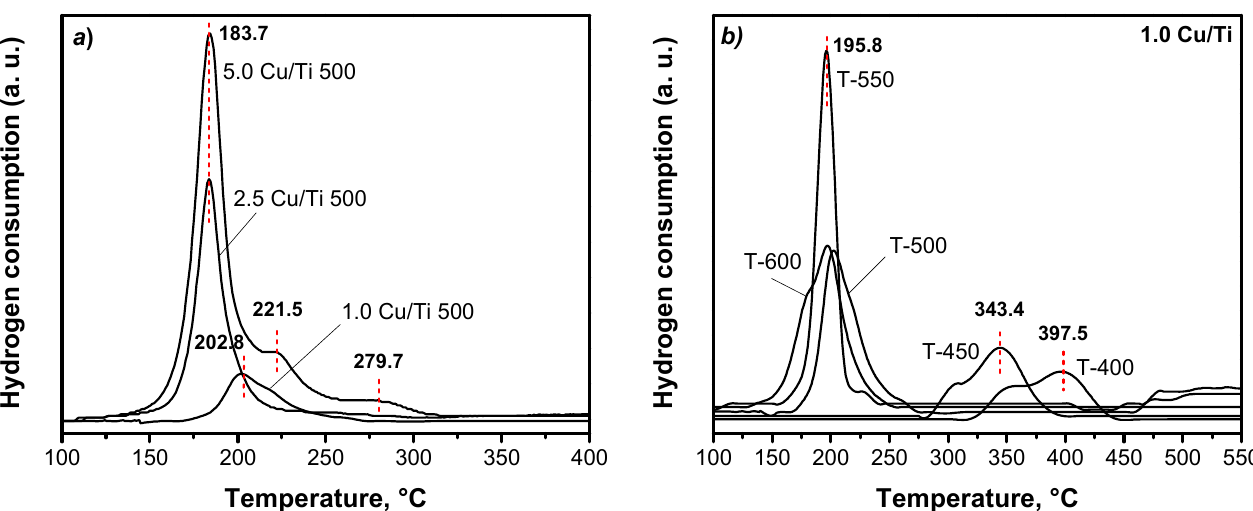
Figure 4. Temperature-programmed reduction of ( a ) X Cu/Ti and ( b ) 1.0 Cu/Ti Y photocatalysts.